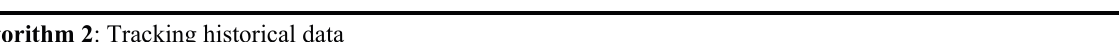
Algorithm 2 : Tracking historical data Input: current status observation SO